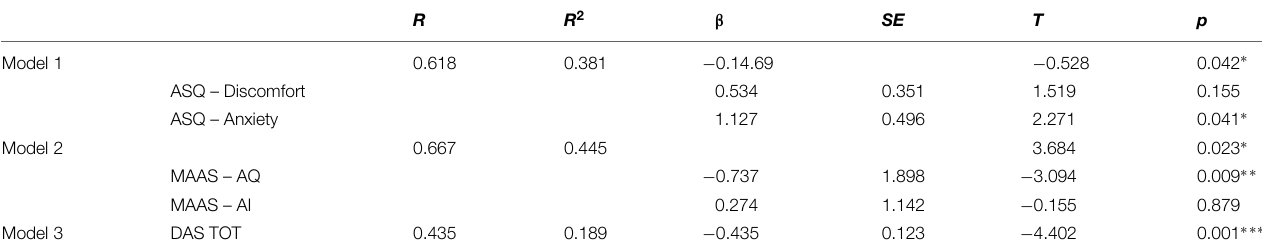
TABLE 4 | Results of regression analyses for antenatal measures on the Parenting Stress Index, Total Score, at 3 months after childbirth. R R